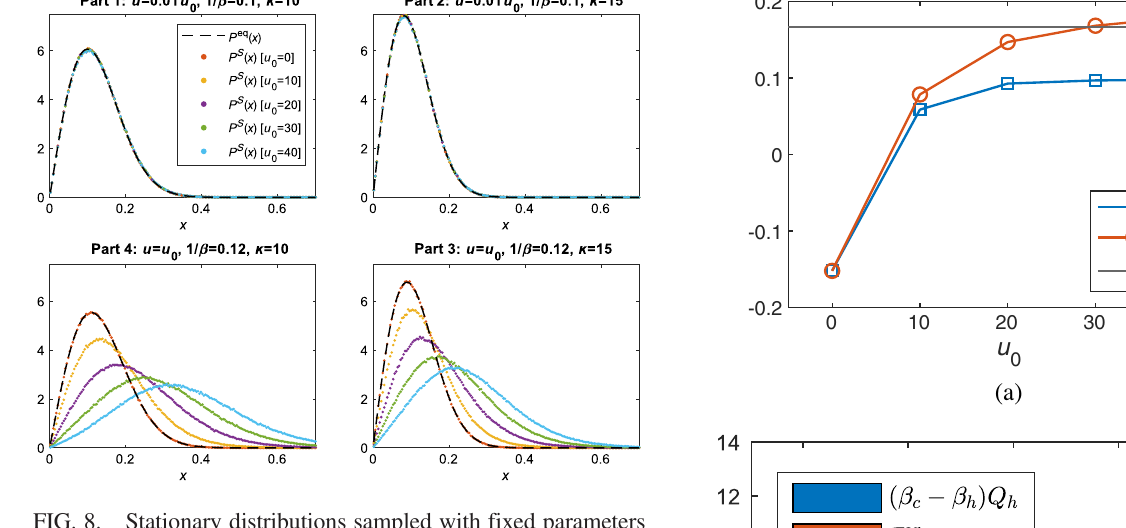
FIG. 8. Stationary distributions sampled with fixed parameters according to each of the four steps of the protocol. The reference active speed u 0 corresponds to different curves indicated by color. The equilibrium distribution is shown as a dashed black curve. For parts 1 and 2, the stationary distribution are closer to the equilibrium distribution due to the small driving speed u .